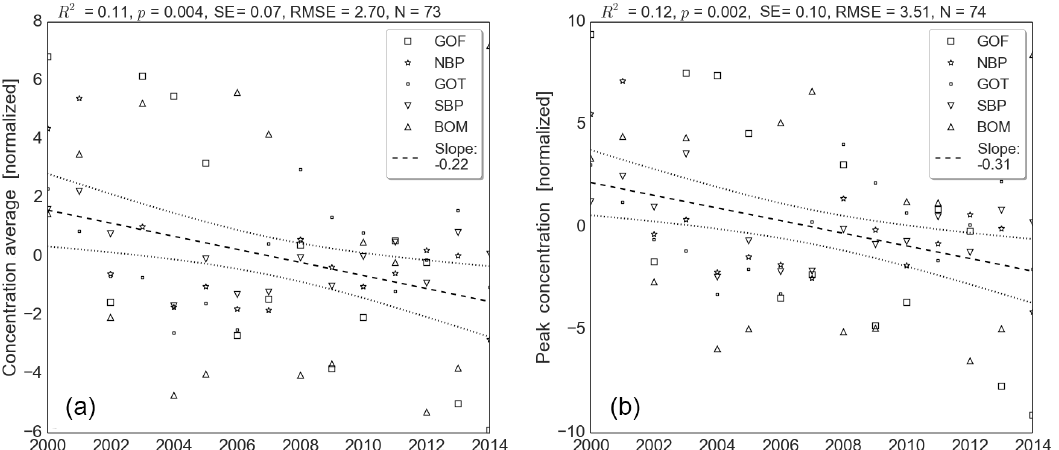
Figure 6. (a) Decadal trend of average (concavg) and (b) peak (peakheight) chlorophyll a concentration during bloom conditions, derived from the Weibull-distribution metric. Concentrations were normalized prior to regression (subtraction of area-average concentration). Dashed lines indicate the trend line (bold) and its confidence intervals (5%, small dashes). SE denotes standard error; RMSE denotes root mean square